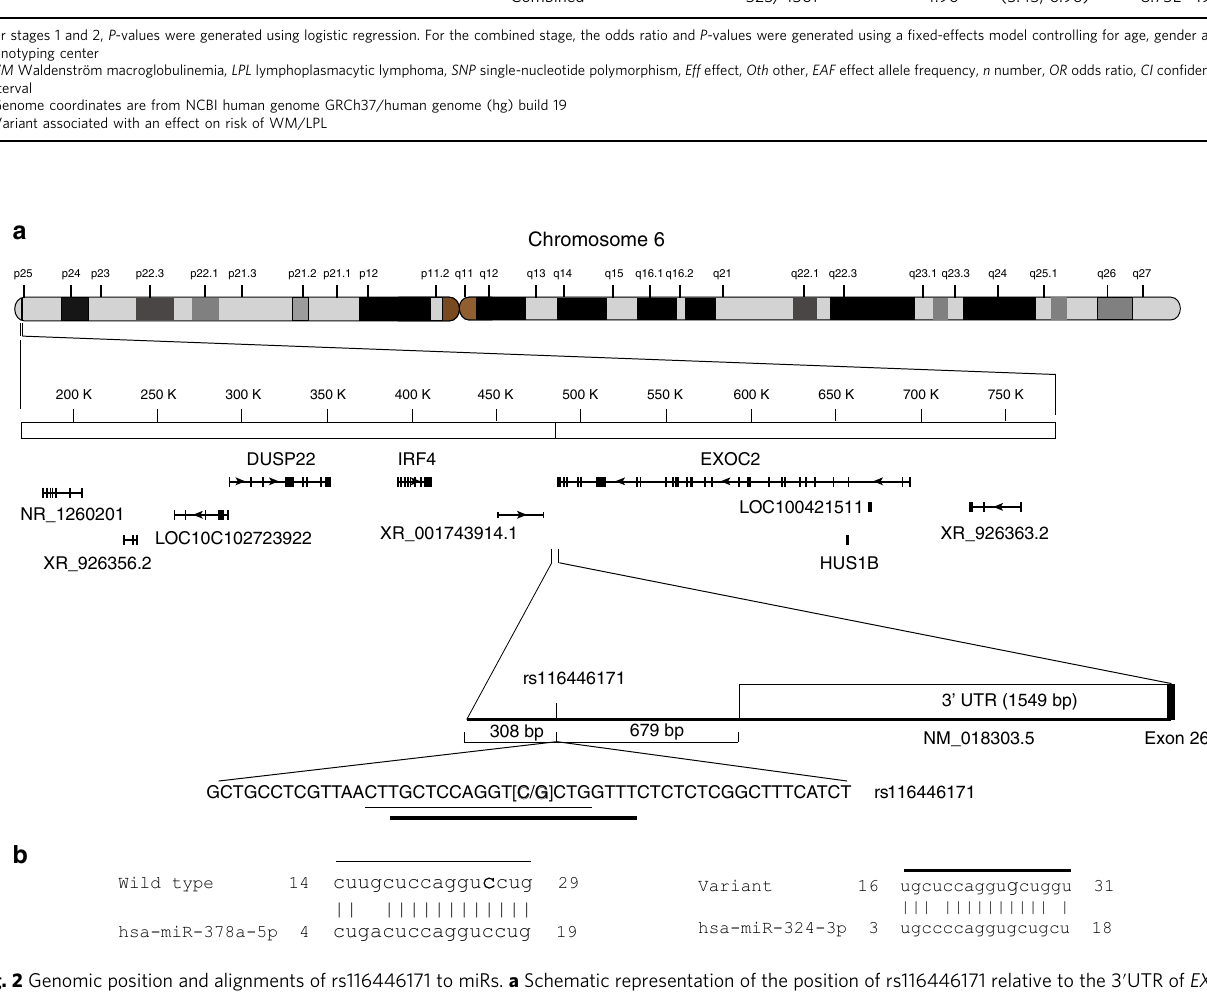
For stages 1 and 2, P -values were generated using logistic regression. For the combined stage, the odds ratio and P- values were generated using a fi xed-effects model controlling for age, gender and genotyping center